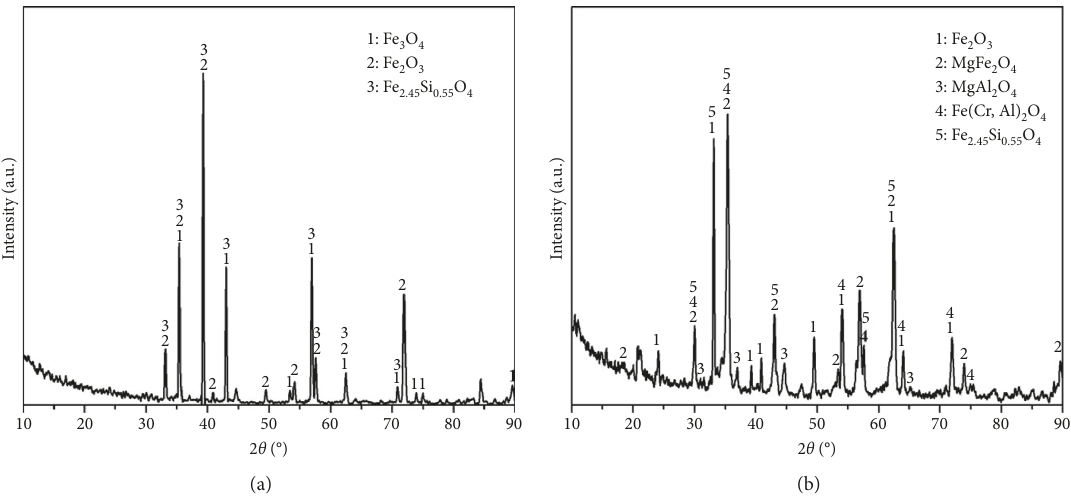
Figure 4: XRD patterns of (a) uncoated sample and (b) coated sample.